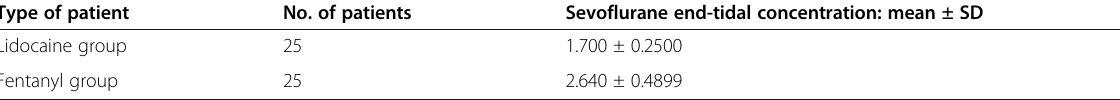
Table 5 Intraoperative end-tidal concentration of sevoflurane Type of